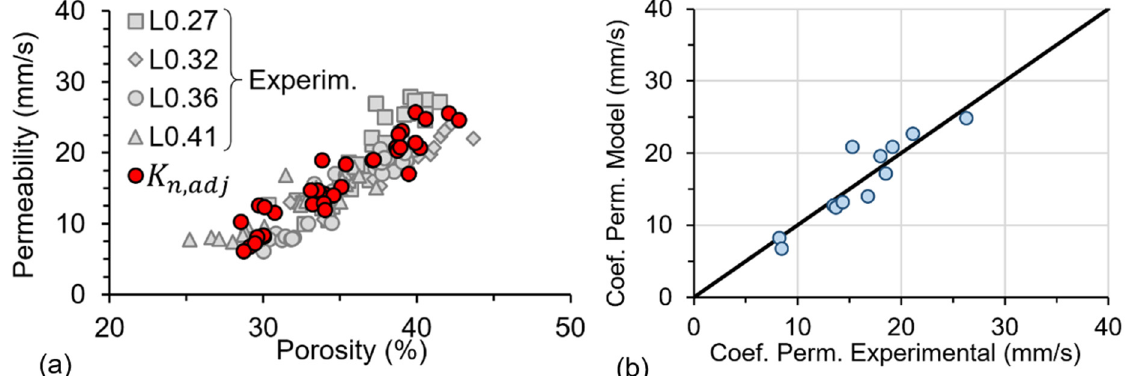
Figure 6 . Experimental and numerical permeability coefficient: a) versus numerical porosity and b) direct comparison